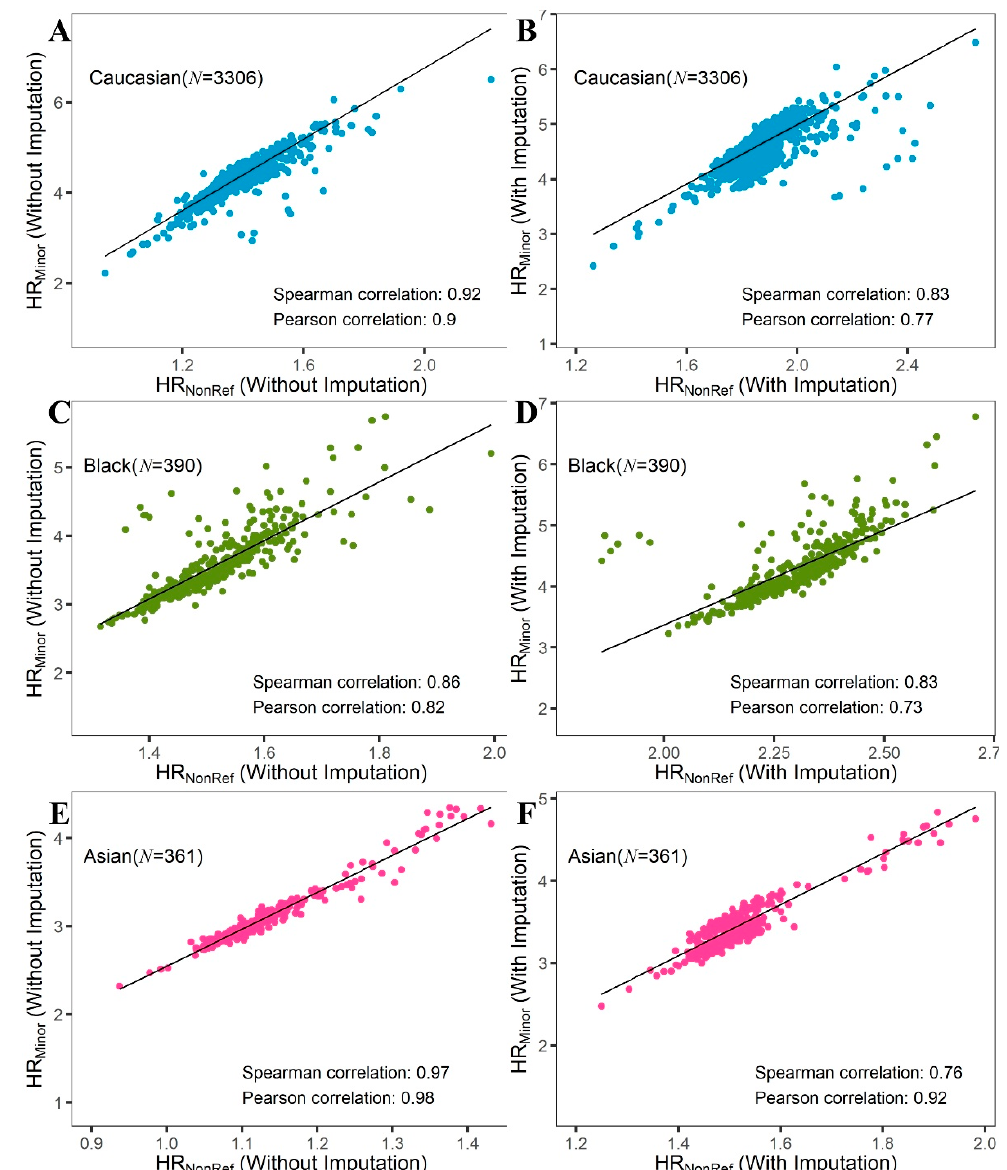
Figure 1. Scatter plots for HR NonRef vs. HR Minor . ( A , B ): Caucasian; ( C , D ): Black; ( E , F ): Asian. ( A , C , E ): Heterozygosity Ratio (HR) computed from original Single Nucleotide Polymorphism (SNP) data without imputation. ( B , D , F ): HR computed from SNP data after imputation. Each data point is an individual in the cohort. All results show excellent correlations between HR NonRef and HR Minor , with HR Minor two to three times higher than HR NonRef .